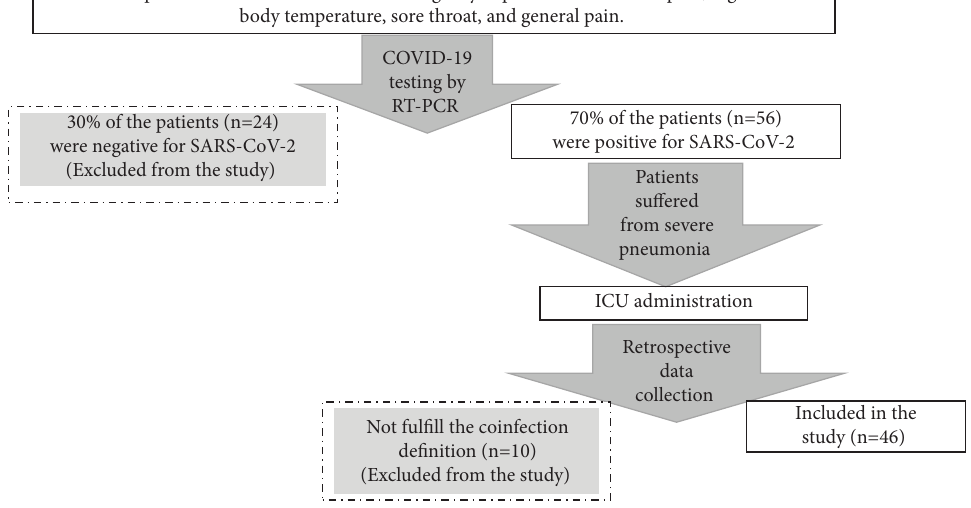
Figure 1: Flow chart for inclusion of the study